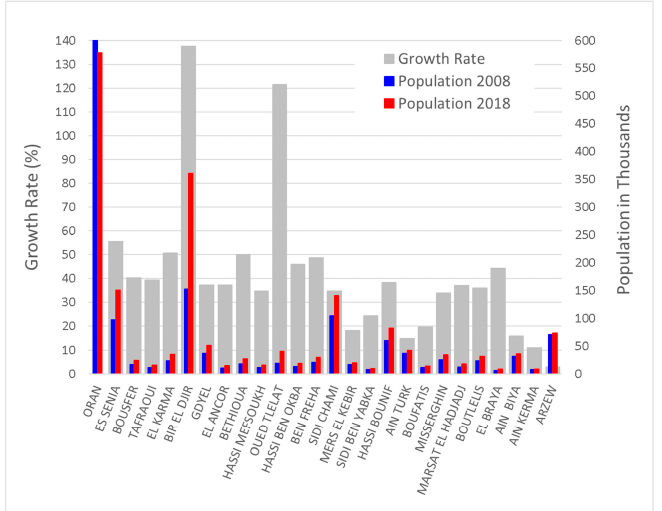
Figure 8. Population (thousands of persons) and growth rate (%) for the communes in the Oran wilaya between 2008 and 2018.